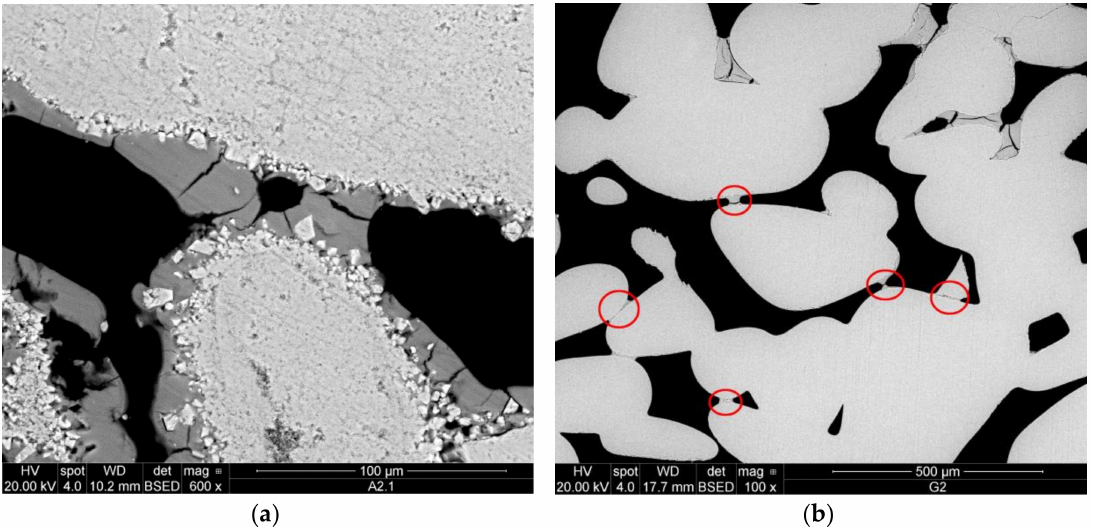
Figure 11. SEM-BSE micrographs showing: ( a ) very good adhesion and capacity to form bridges of nanocalcite on Au limestone; ( b ) silicate filter disc with small bridges of nanocalcite and moderate shrinkage properties of the